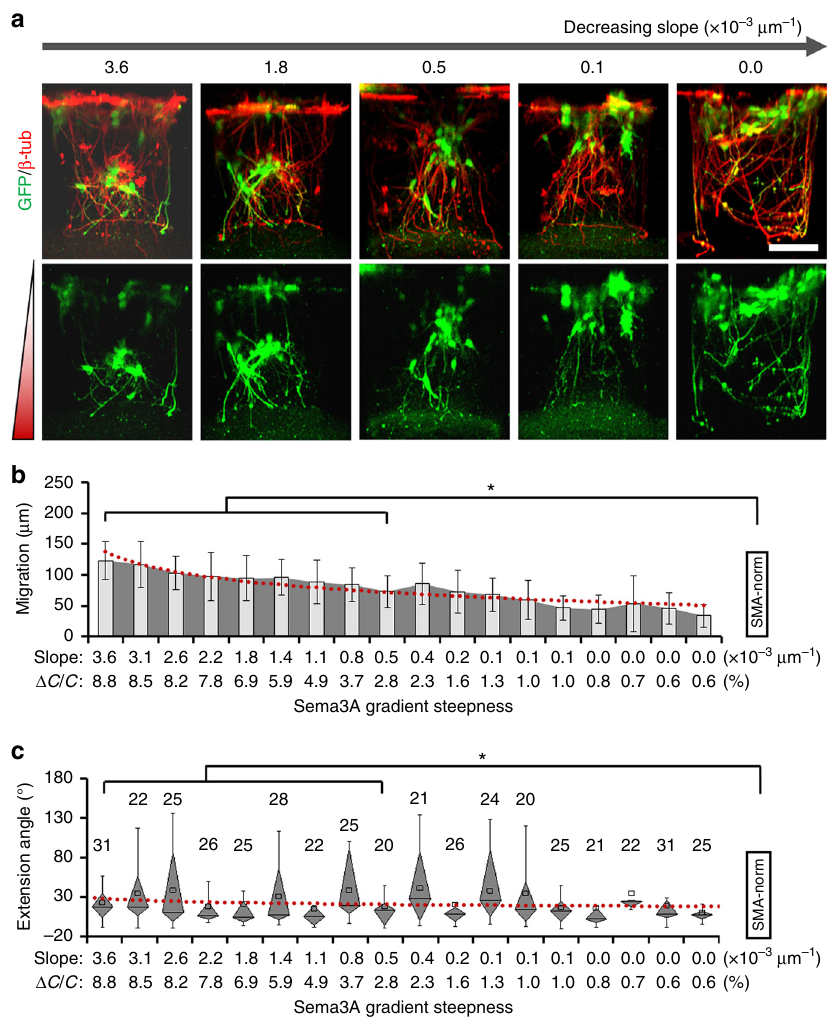
Fig. 5 STK11 affects Sema3A-induced chemorepellence of neurite outgrowth. a Fluorescence images of neurons in a Sema3A gradient of various steepness after STK11 knockdown. Scale bar: 100 µ m. b Quantitative analysis of STK11 ’ s role in neuronal migration and related association with Sema3A gradient steepness, n = 3, error bars indicate standard deviation. c Box-plots for quantitative analysis of STK11 ’ s role in the chemorepellent guidance of neurite outgrowth in response to varied Sema3A gradient steepness. The parts of the box indicate 25, 50, and 75 percentiles, and the whiskers indicate 5% and 95%. The square mark indicates mean of the data. More than 20 neurites (as indicated on top of each box) were pooled from three biological replicates. For b , c , the red line indicates logarithmic fi tting of the data mean; neuronal growth pattern in each hydrogel cylinder was compared in pairwise to experiments with regular Sema3A treatment (SMA-norm), * indicates a p -value < 0.05 by paired Kruskal –